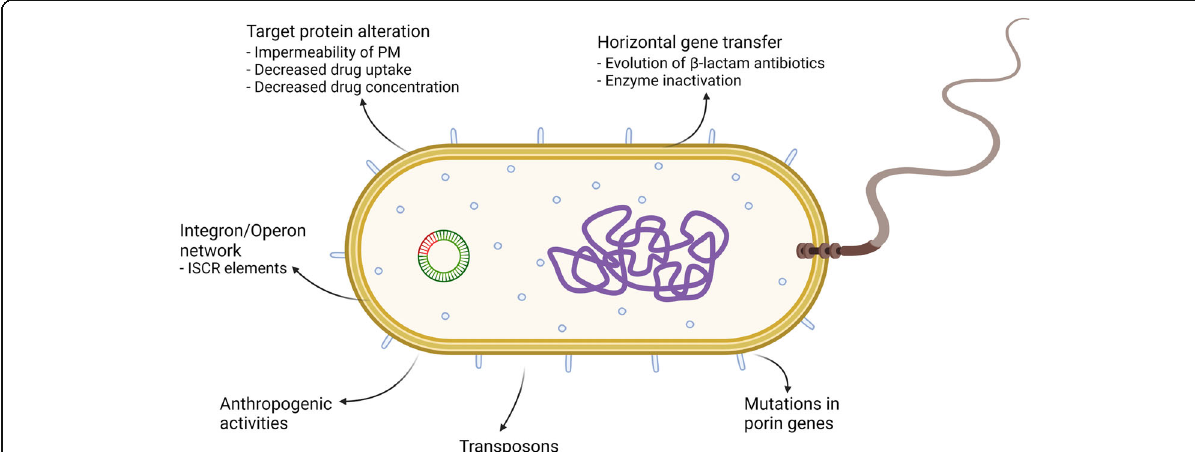
Fig. 1 Drug resistance in bacteria. Target protein alteration. Certain modifications lead to impermeability of the cell membrane and thus decrease drug uptake. Target modification leads to a demoted drug binding. Integron Operon network. Integrons help insert a resistance gene at a pre- decided site downstream of a promoter (Example- Tn21 ). Anthropogenic activities. Release of toxic chemicals into the environment provides a selection and survival pressure which leads to variation and ultimately, evolution. Horizontal gene transfer. Transfer of genes from other species or from same species, but not parental cells is called HGT. Evolution of β -lactam antibiotic resistance genes is one of the results of HGT. Transposons. “ Jumping genes ” produces enzymes that aid in HGT. Mutation in porin genes. It can lead to decreased drug influx or increased drug efflux with the help of ion motive force, as compared to ATP hydrolysis by